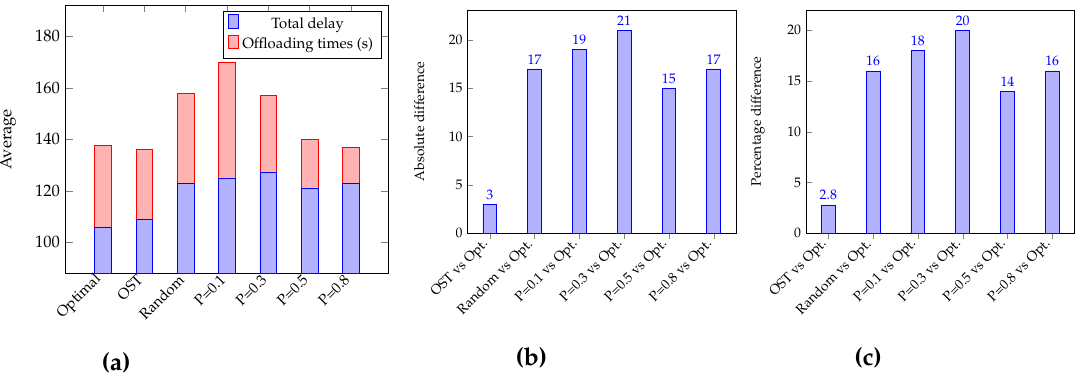
Figure 5. ( a ) Average total delay and average offloading times suggested by each model; ( b ) absolute difference between the Optimal and all models; ( c ) percentage difference between the Optimal and all models in Random mapping results.